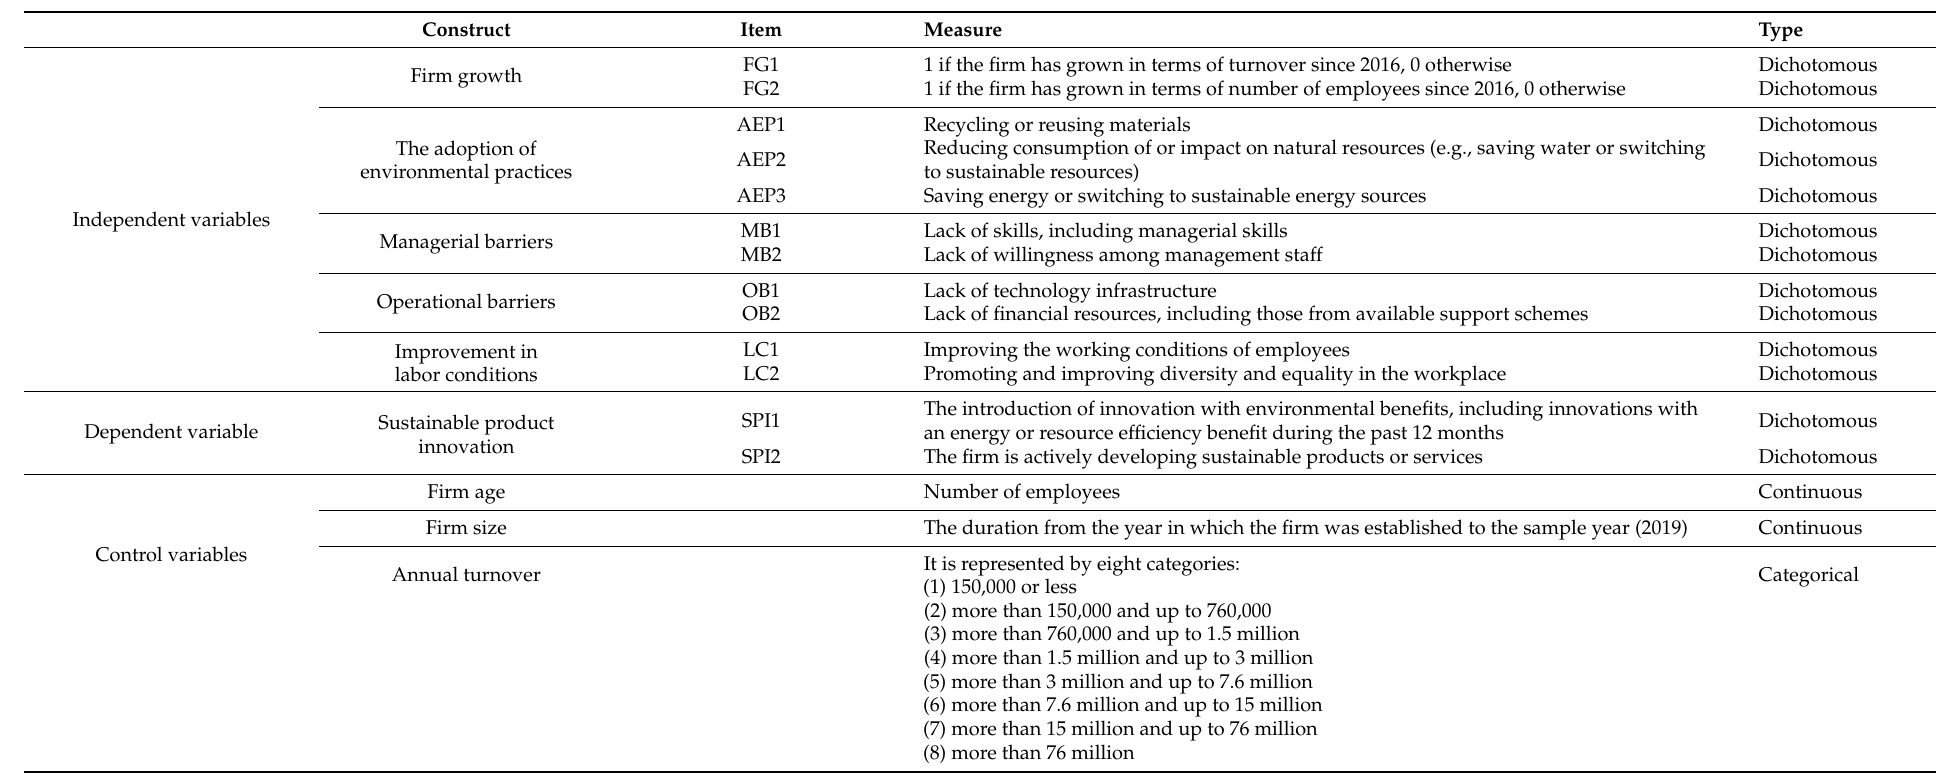
Table A1. Variable